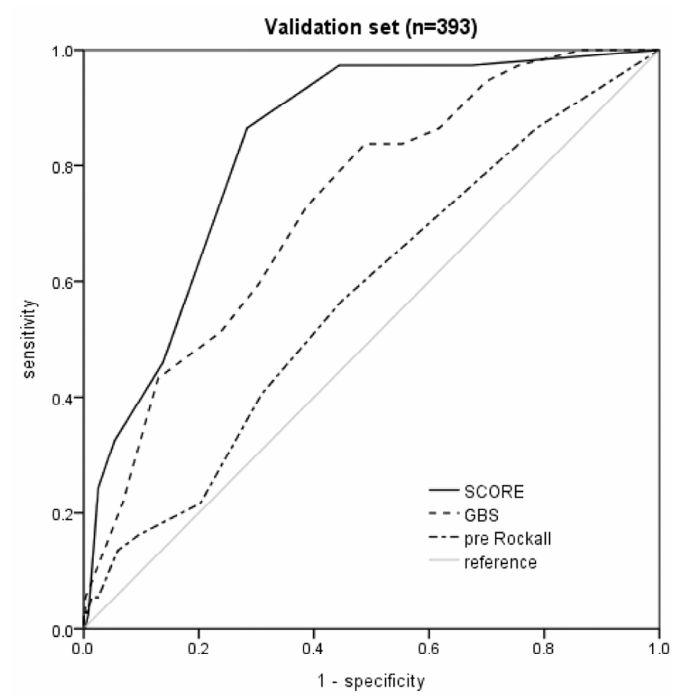
Figure 3. Comparison of the predictive ability of the new score with that of the GBS and the pre-endoscopy Rockall score in predicting the occurrence of hypotension in the validation set. GBS, Glasgow–Blatchford score. Table 4. Test of accuracy of cutoff value in the validation set.